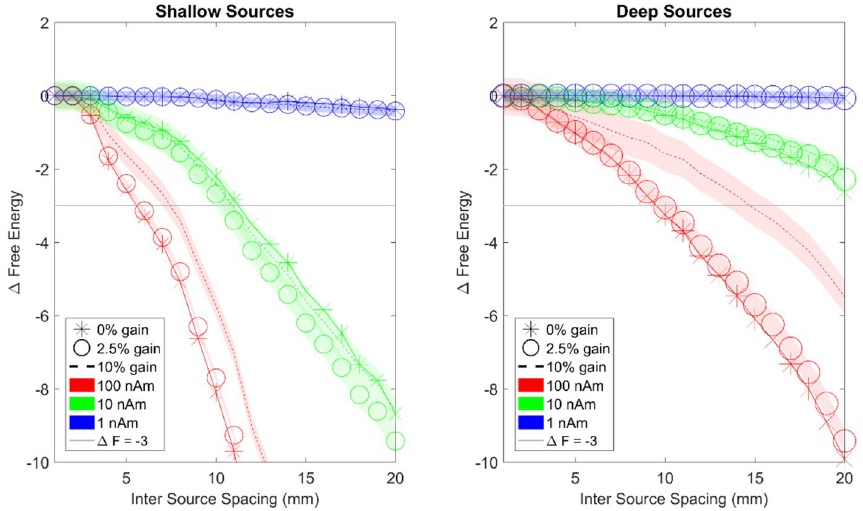
Figure 6. The relationship between gain errors and spatial discrimination of OP-MEG systems for shallow (left panel) and deep sources (right panel). The x axis is inter-source spacing and the y axis shows change in free energy. The point at which the curves cross the F = − 3 line shows the distance at which the true and competing source models can be confidently distinguished. High, moderate and low SNR are signified by red green and blue curves, respectively. The thickness represents standard error. Stars represent 0% gain error, circles represent 2.5% gain error and dotted lines represent 10% gain error. The horizontal light grey lines represent the free energy threshold of − 3 that defines the spatial discrimination of the array. The same symbols and colour schemes are used for the right panel to describe deep sources. Noticeable differences in discrimination due to gain errors are only discernible at high SNR.